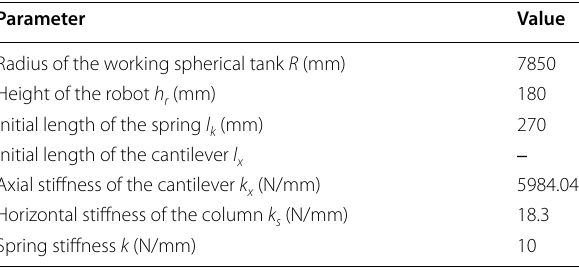
Table 3 Equation parameters